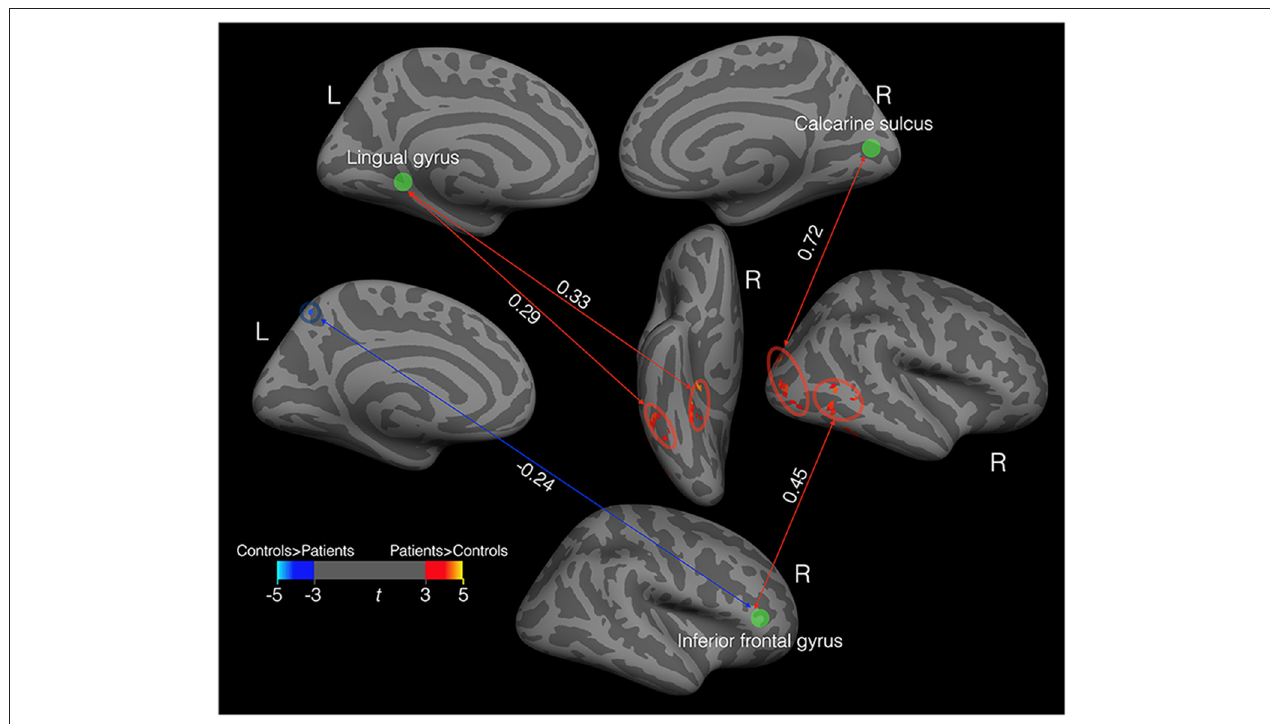
FIGURE 3 | Functional connectivity in the patients ( N = 11) that deviated from that in controls. The green discs indicate three spheric ROIs centered on the peak voxels of vertex clusters exhibiting significant differences in cortical thickness between patients and controls. The red ovals enclosed areas with stronger positive connectivity in patients than in the controls. The blue circle enclosed an area with stronger negative connectivity in patients than in the controls. All the correlation values (the white numbers) are significantly different from zero and significantly deviate from the corresponding correlation values in the controls.